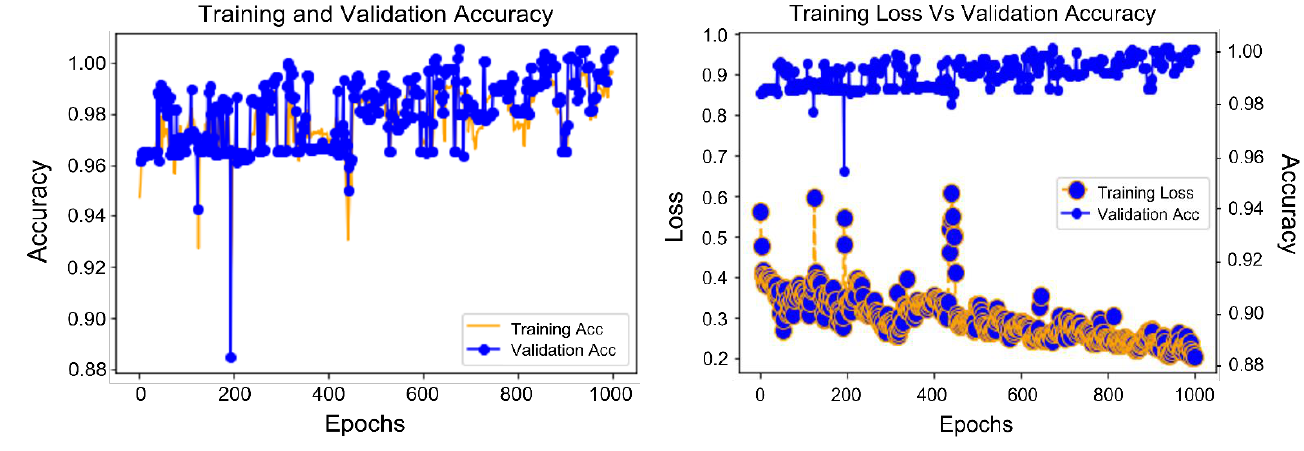
Figure 9. Validation accuracy vs. training loss and training accuracy results with 1000 epochs.